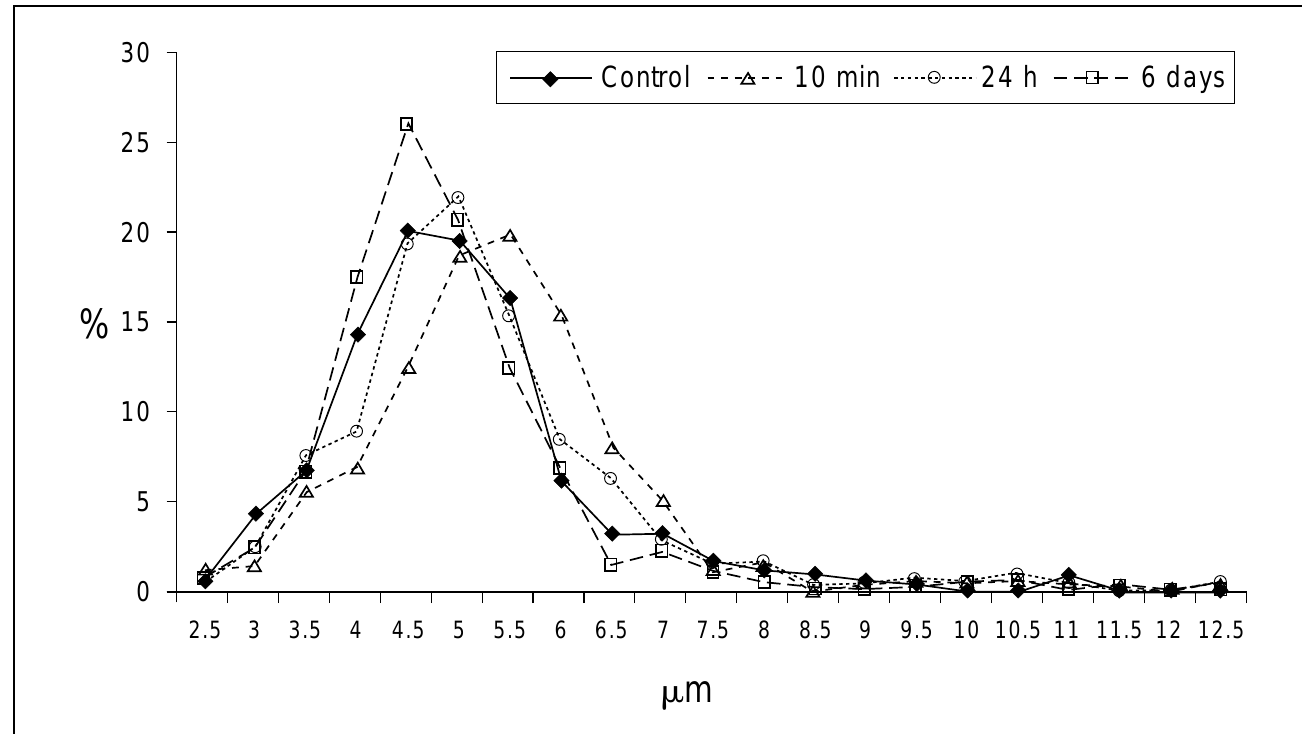
Figure 2: Frequency distribution (%) of capillary diameters ( (cid:2) m ) in control muscle and muscle 10 minutes, 24 hours and 6 days after treatment.